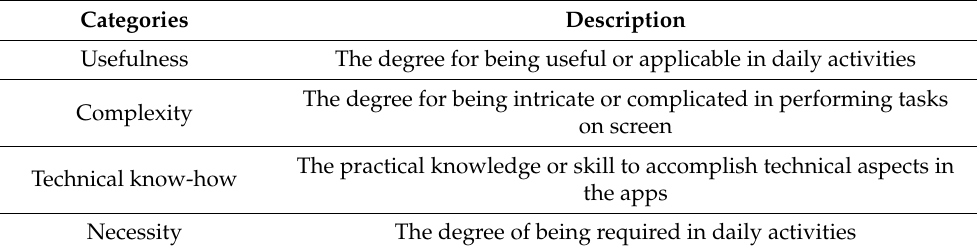
Table 3. The challenges and their